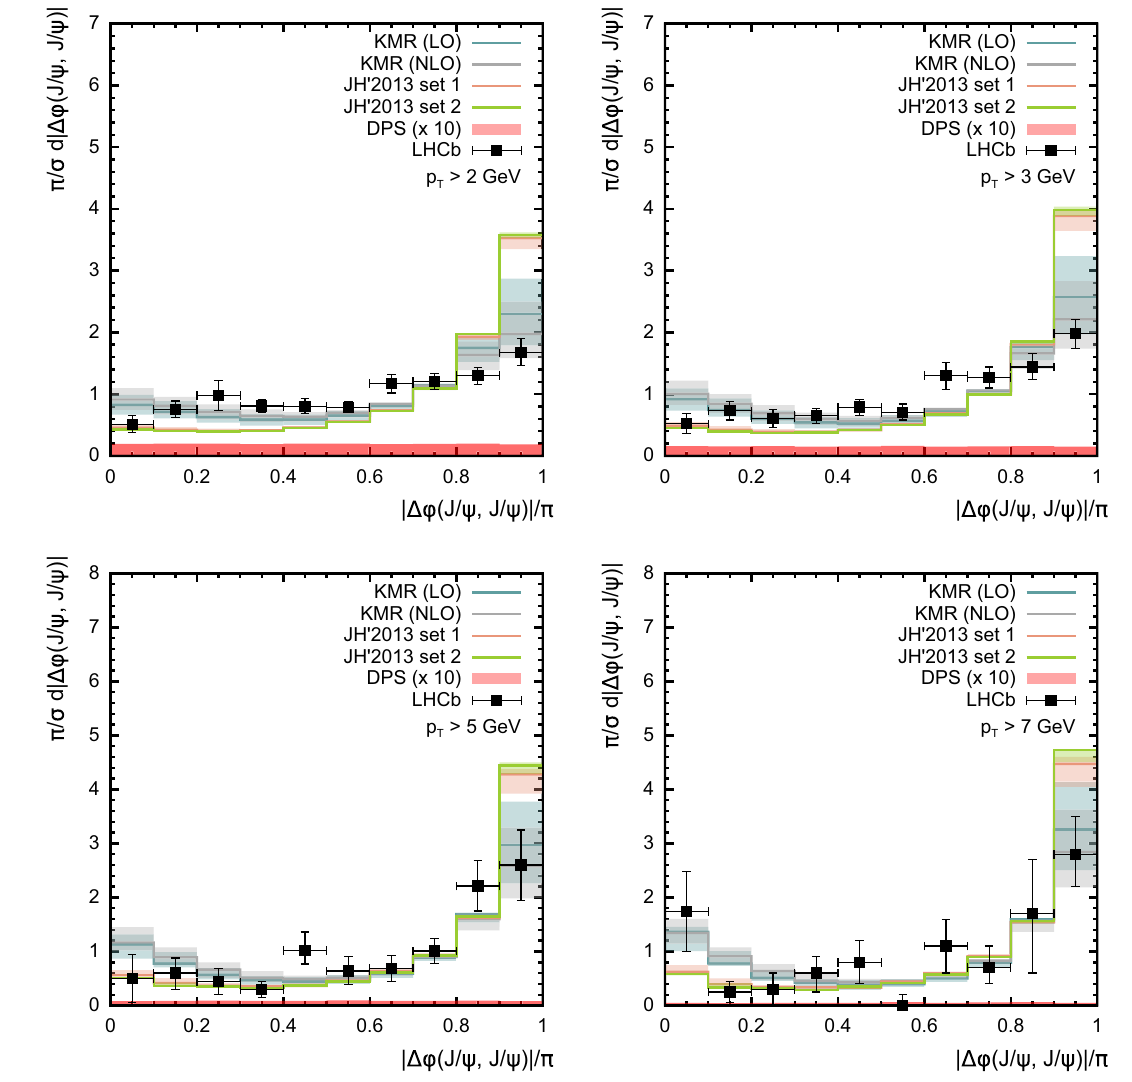
√ s = 8 TeV as a function of the difference in the